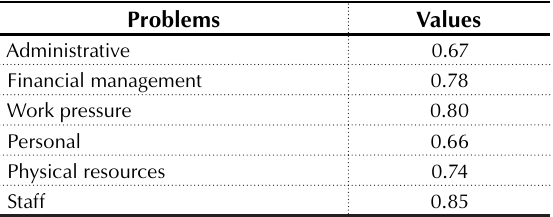
Table 1. Cronbach’s alpha values of serious problems for deputy